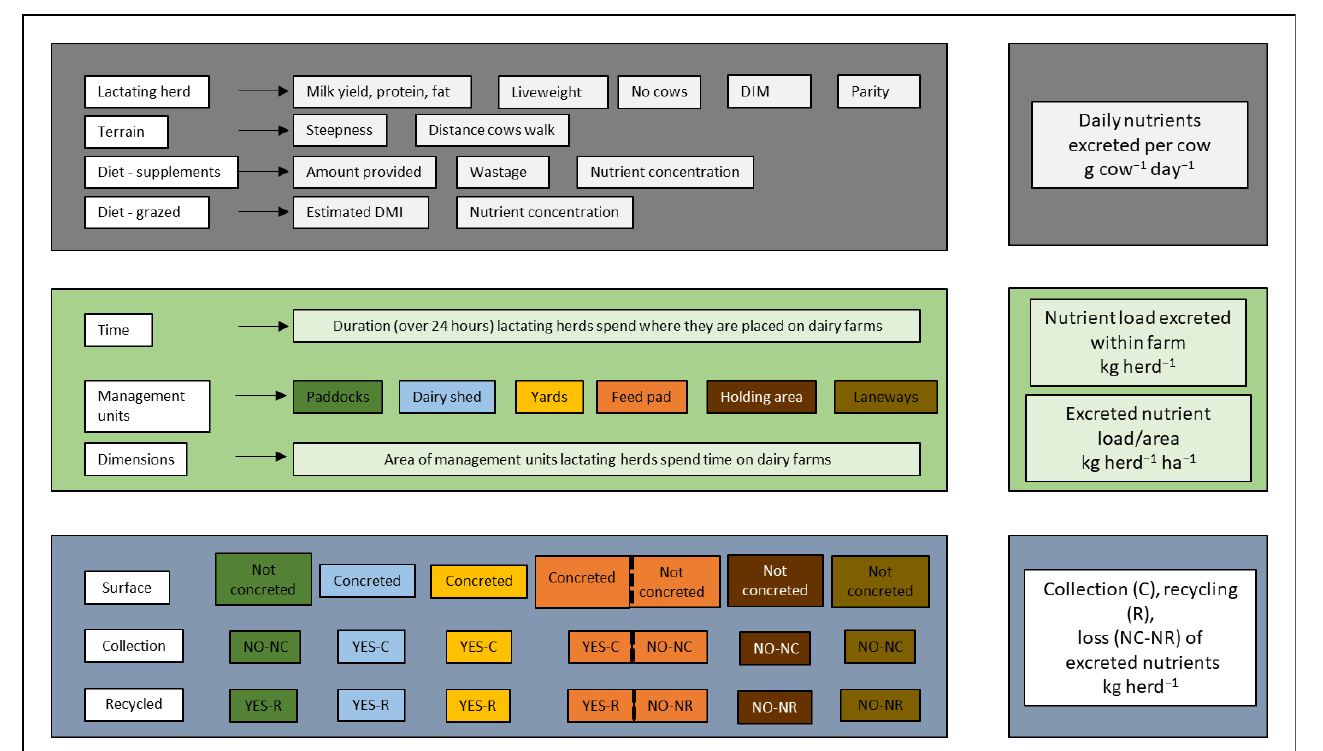
Figure 1. Model consisting of three sub–models showing data used to estimate daily nutrients excreted (g cow −1 day −1 ), excreted loads, (kg herd −1 ) and rate (kg herd −1 ha −1 ) in management units [16], and potential for collection (C), recycling (R), loss (NC–NR) from management units (kg herd −1 ).